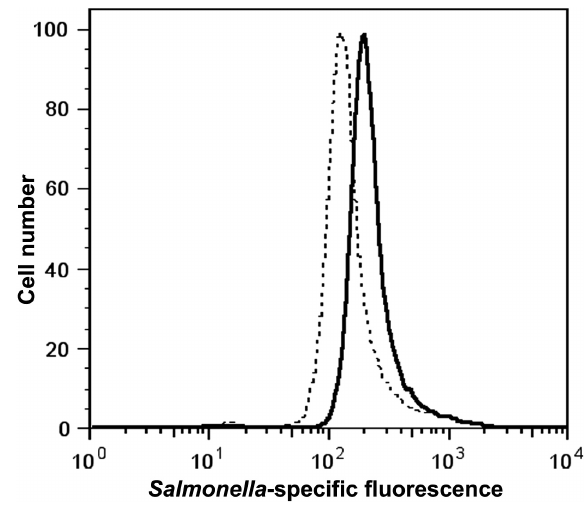
Figure 1 . Cooperative binding of probes Sal3 and Salm-63. From our cytometric screening of multi-probe cocktails, we observed that the combination of Sal3 and Salm-63 was unexpectedly bright. Noting the physical proximity of the binding sites (Sal3: